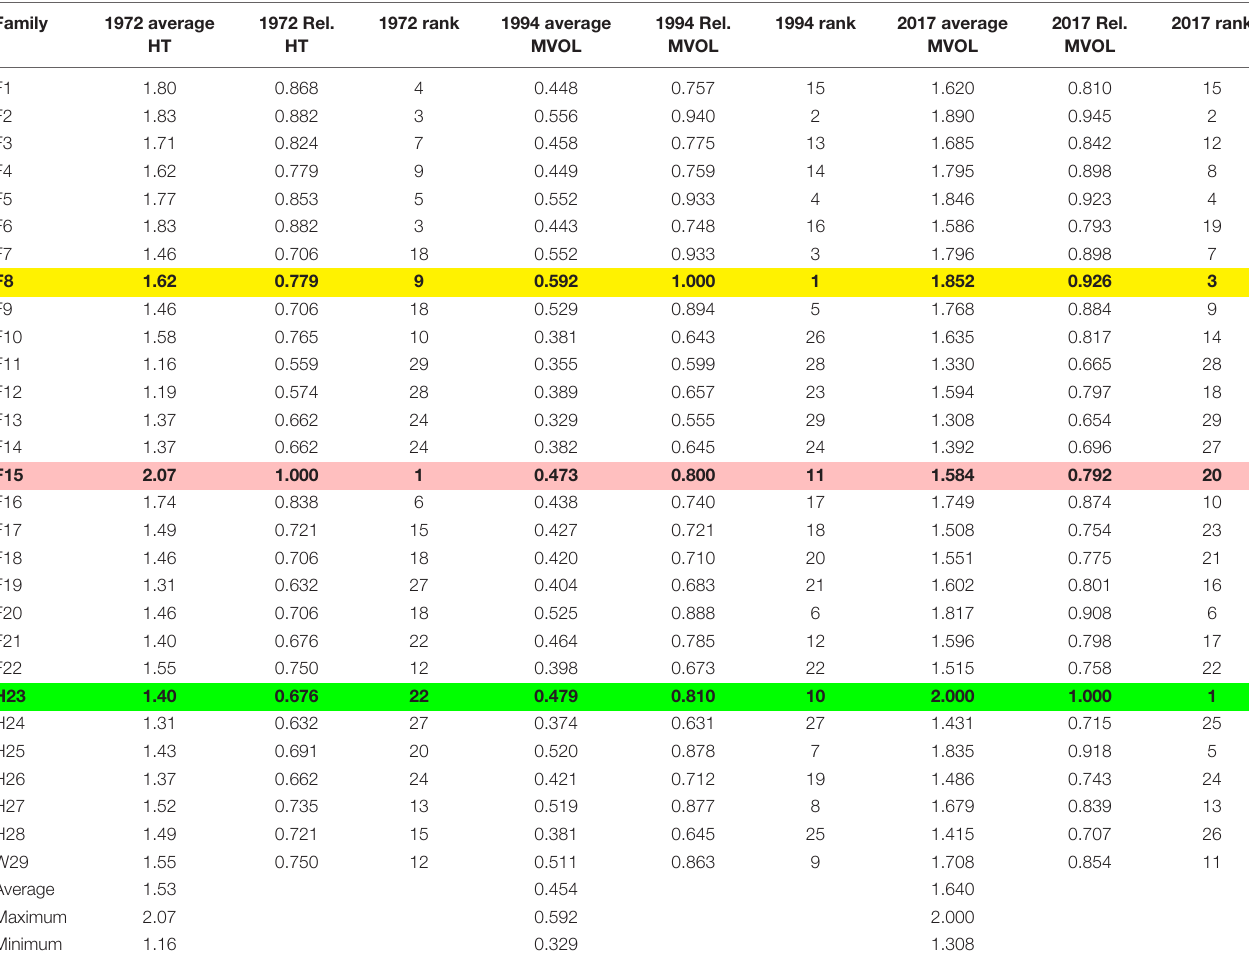
TABLE 6 | Change in measures used to evaluate average and relative (Rel.) growth performance in CEF superior pine progeny tests, with relative based on the best performing family (maximum family-averaged performance). Family 1972 average 1972 Rel. HT